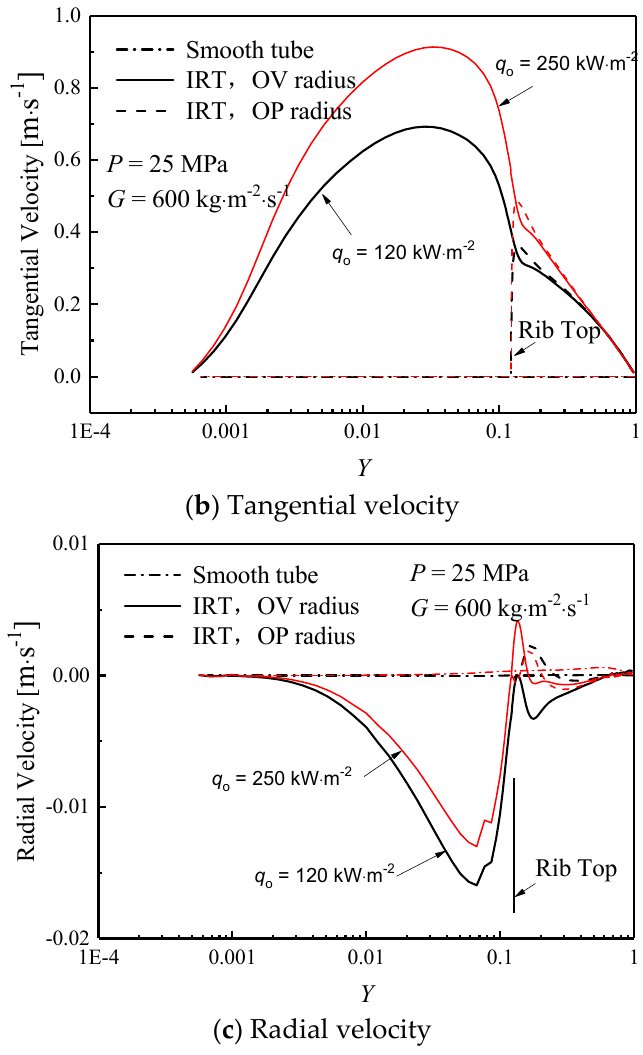
Figure 9. Comparison of velocity components distribution of supercritical water in IRT and ST.